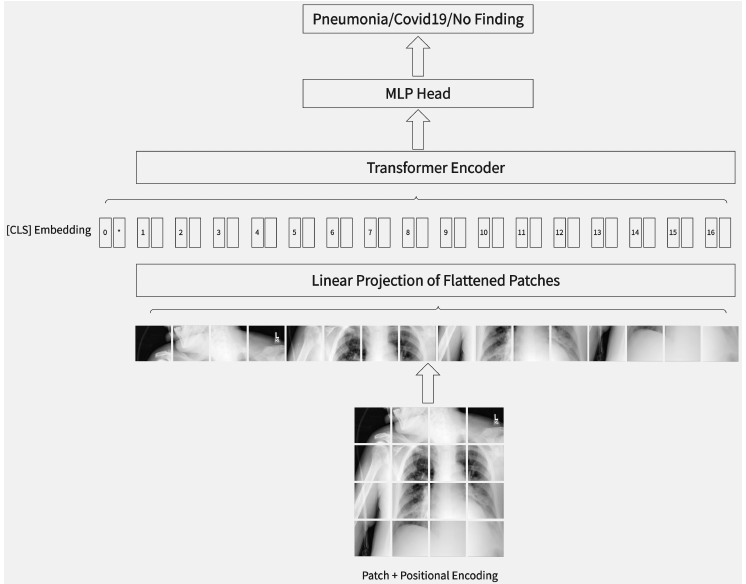
Figure 2. ViT architecture with